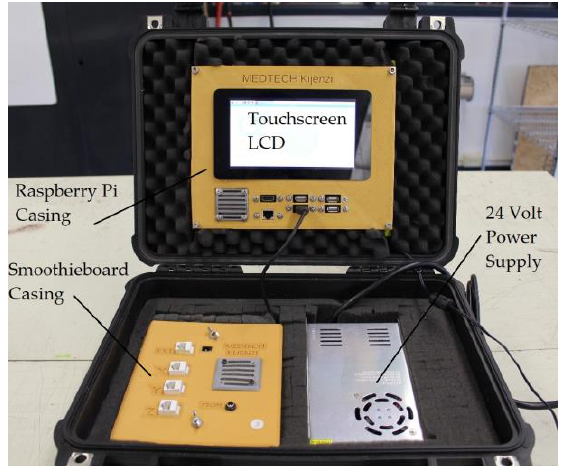
Figure 7. The Control Box for the Kijenzi 3-D printer with Liquid Crystal Display (LCD).